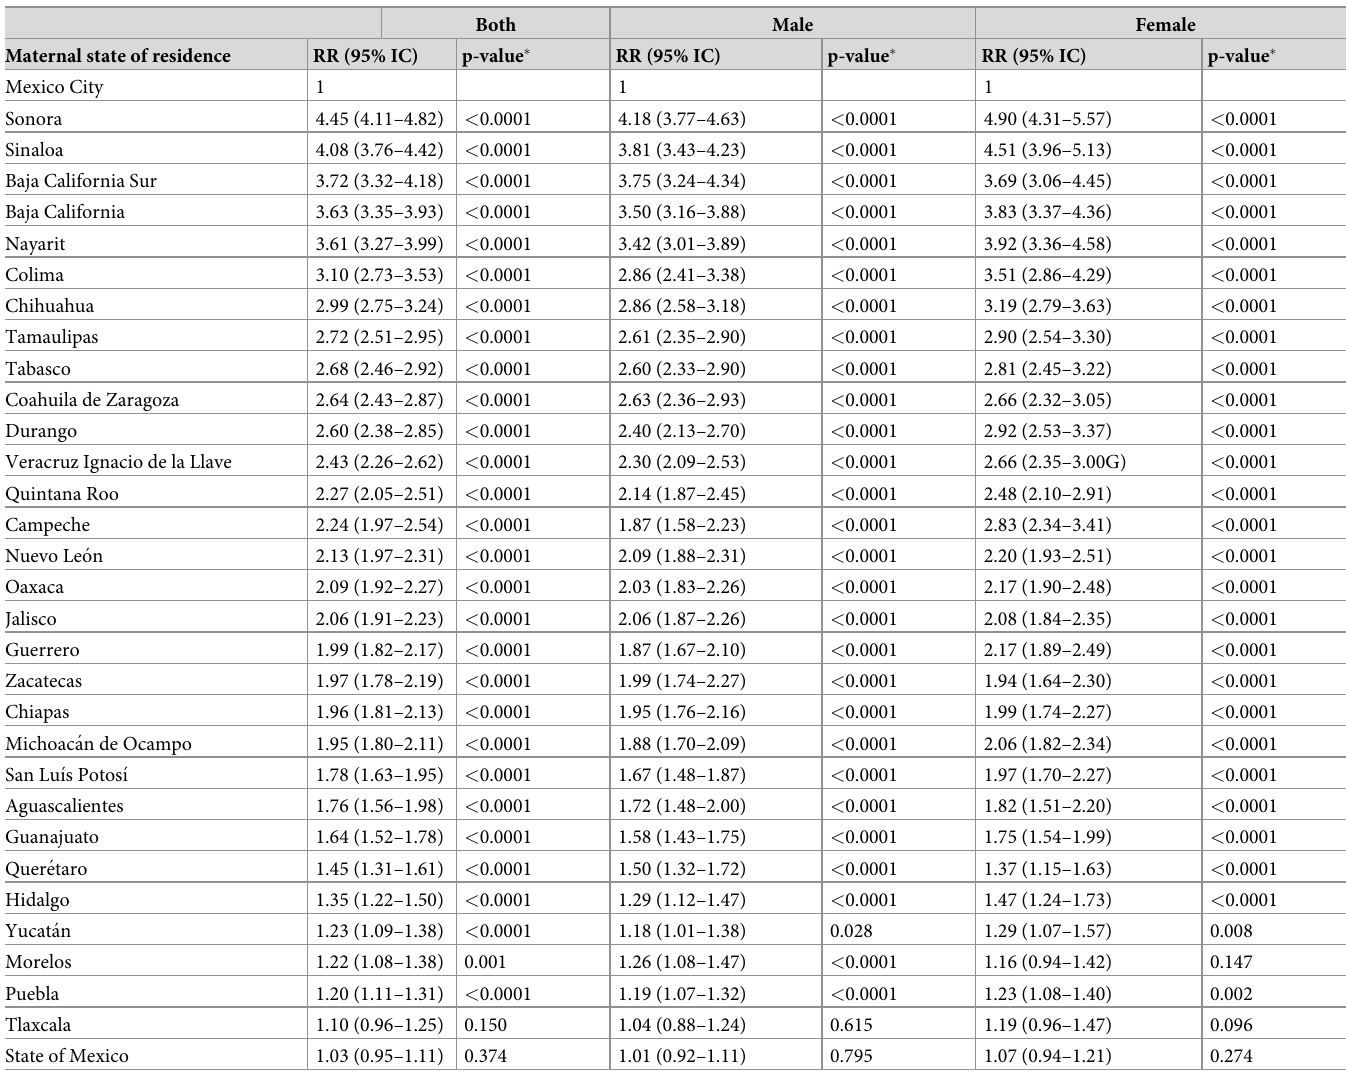
Table 2. Relative risk (RR) of macrosomia by state, Mexico,